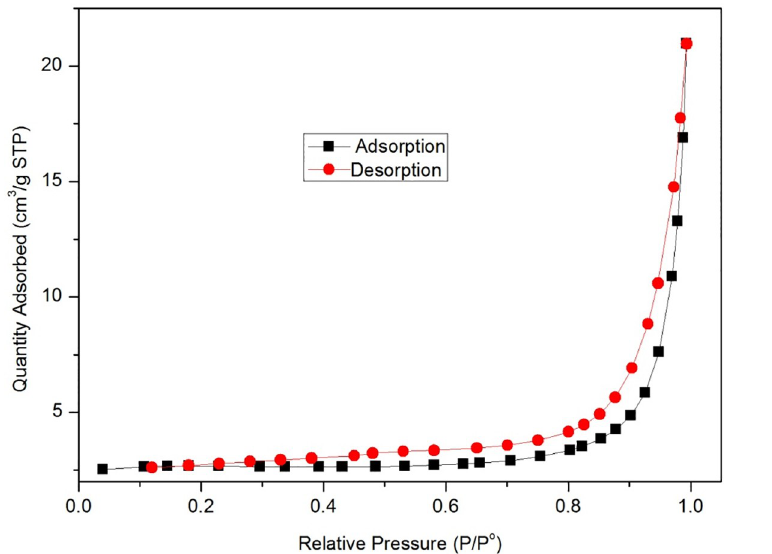
Fig 4. N2 adsorption-desorption isotherms of